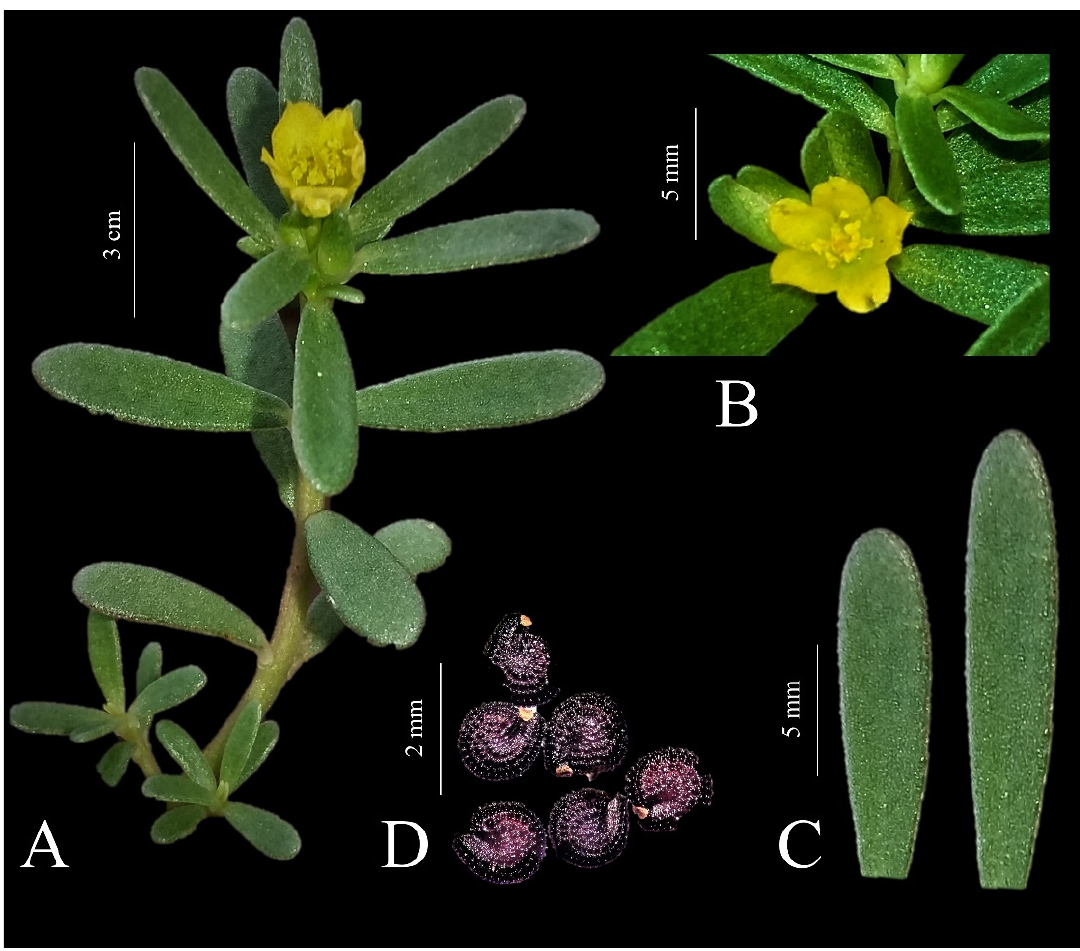
Figure 5. Portulaca oleracea var. linearifolia Sivar. and Manilal. ( A ) Habit; ( B ) flowering branch; ( C ) leaves; ( D ) seeds.